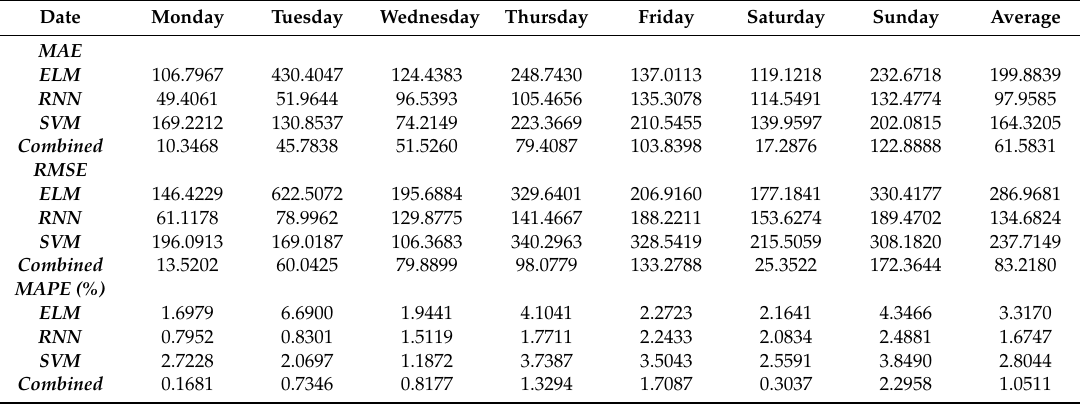
Table 5. Results of the three evaluation metrics of the four models for